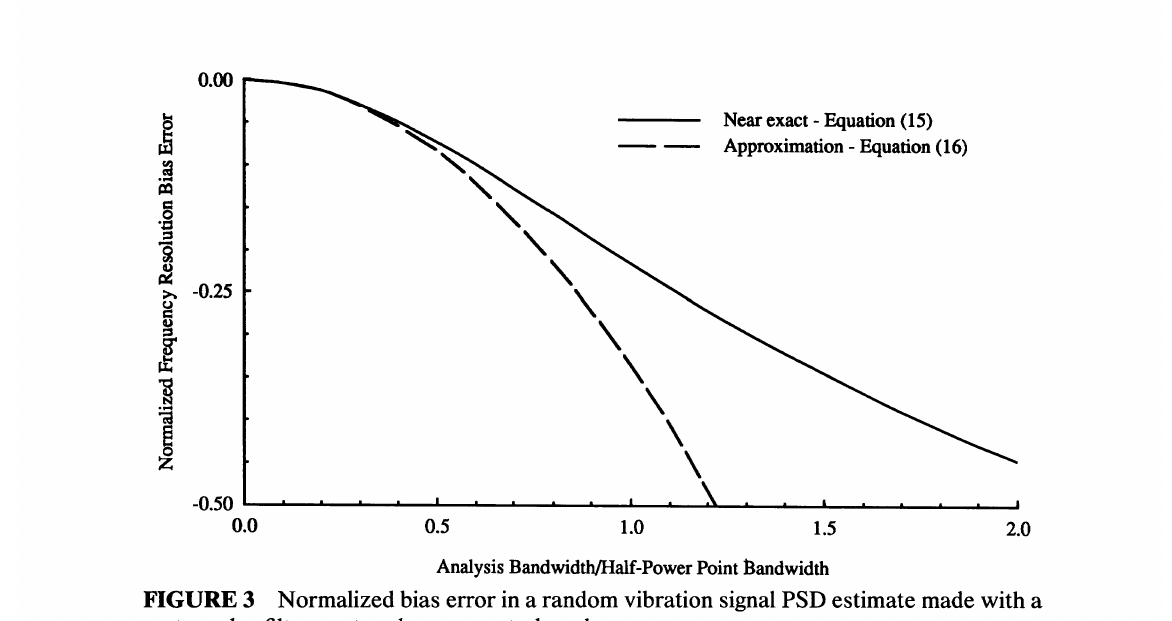
FIGURE 3 Normalized bias error in a random vibration signal PSD estimate made with a rectangular filter centered on a spectral